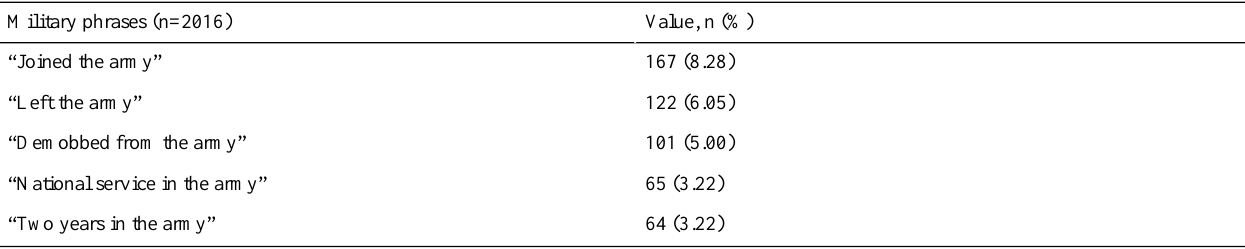
Table 4. Top 5 occurring military phrases identified during manual annotation of the gold standard training dataset.